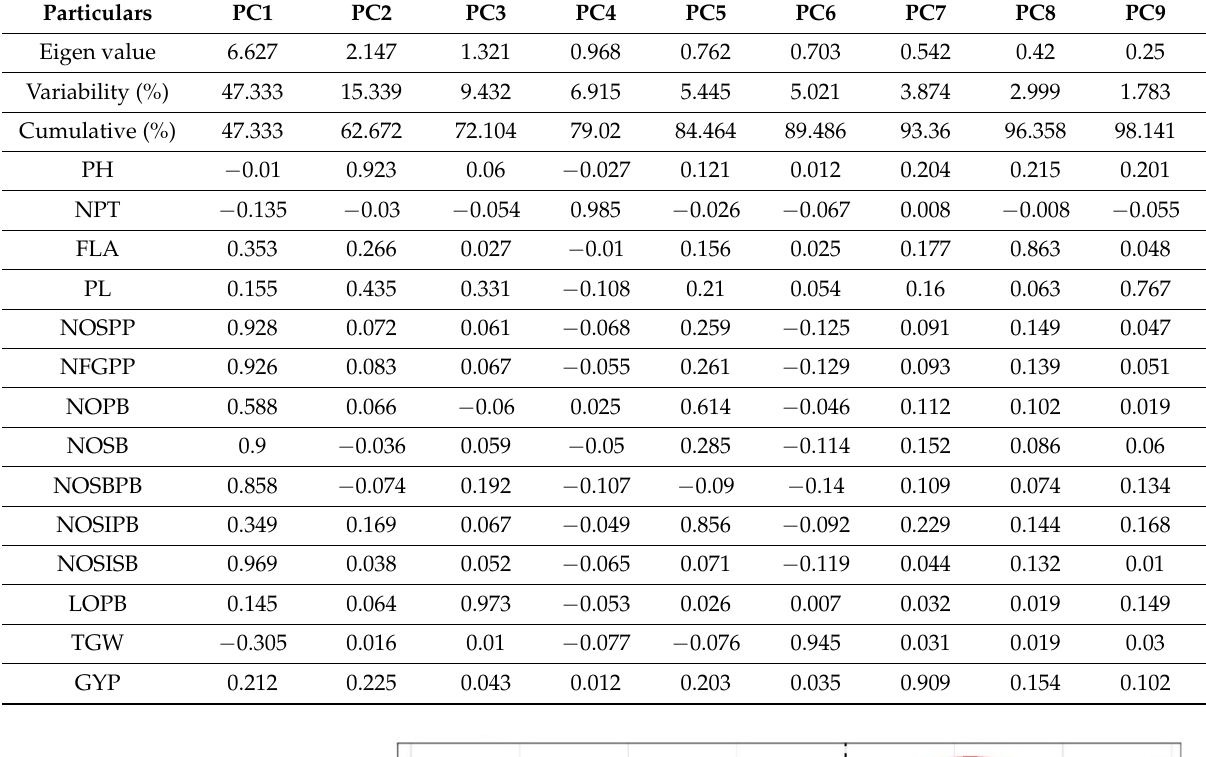
Table 5. The eigenvalue, percentage of variation, cumulative percentage, and eigenvector value for the first 10 principal components.